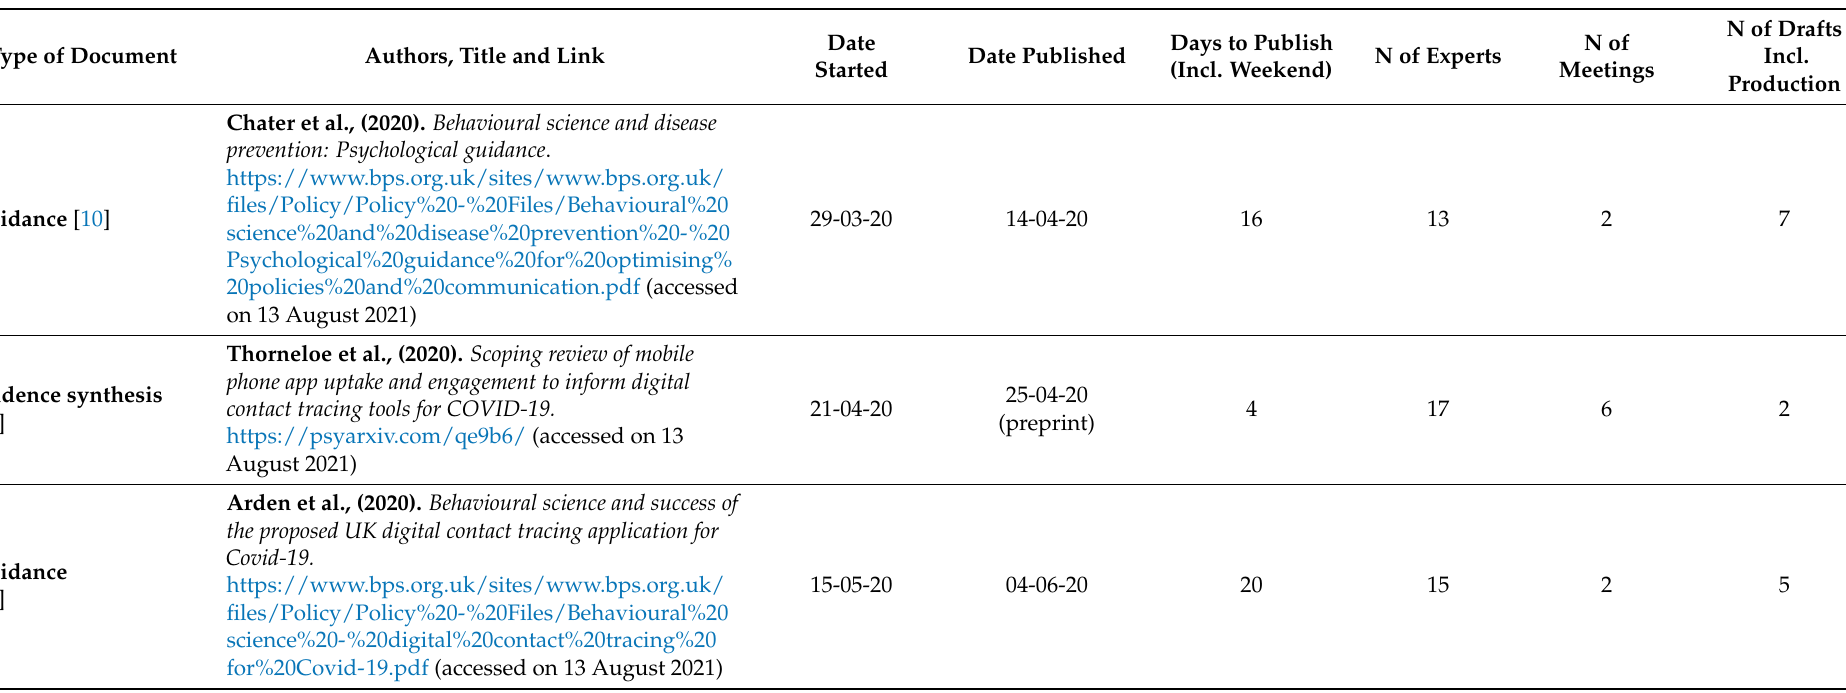
Table 3. Outputs generated from the British Psychological Society COVID-19 Behavioural Science and Disease Prevention Taskforce and the process of rapid consensus for production. Type of Document Authors, Title and Link